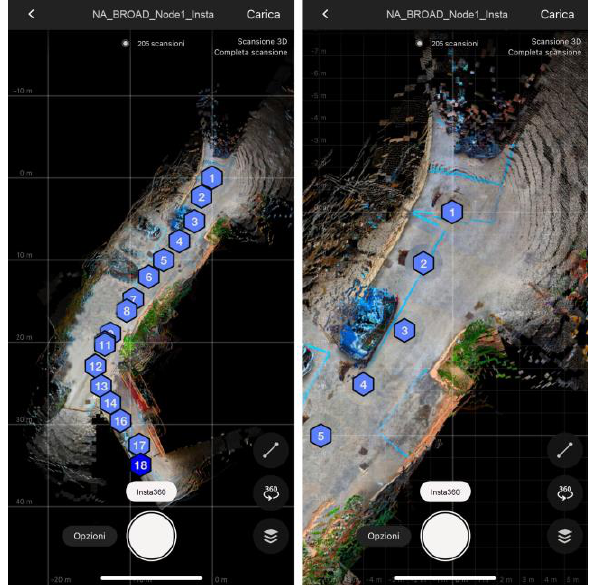
Figure 6 . Station points and point cloud in the interface of the Matterport smartphone